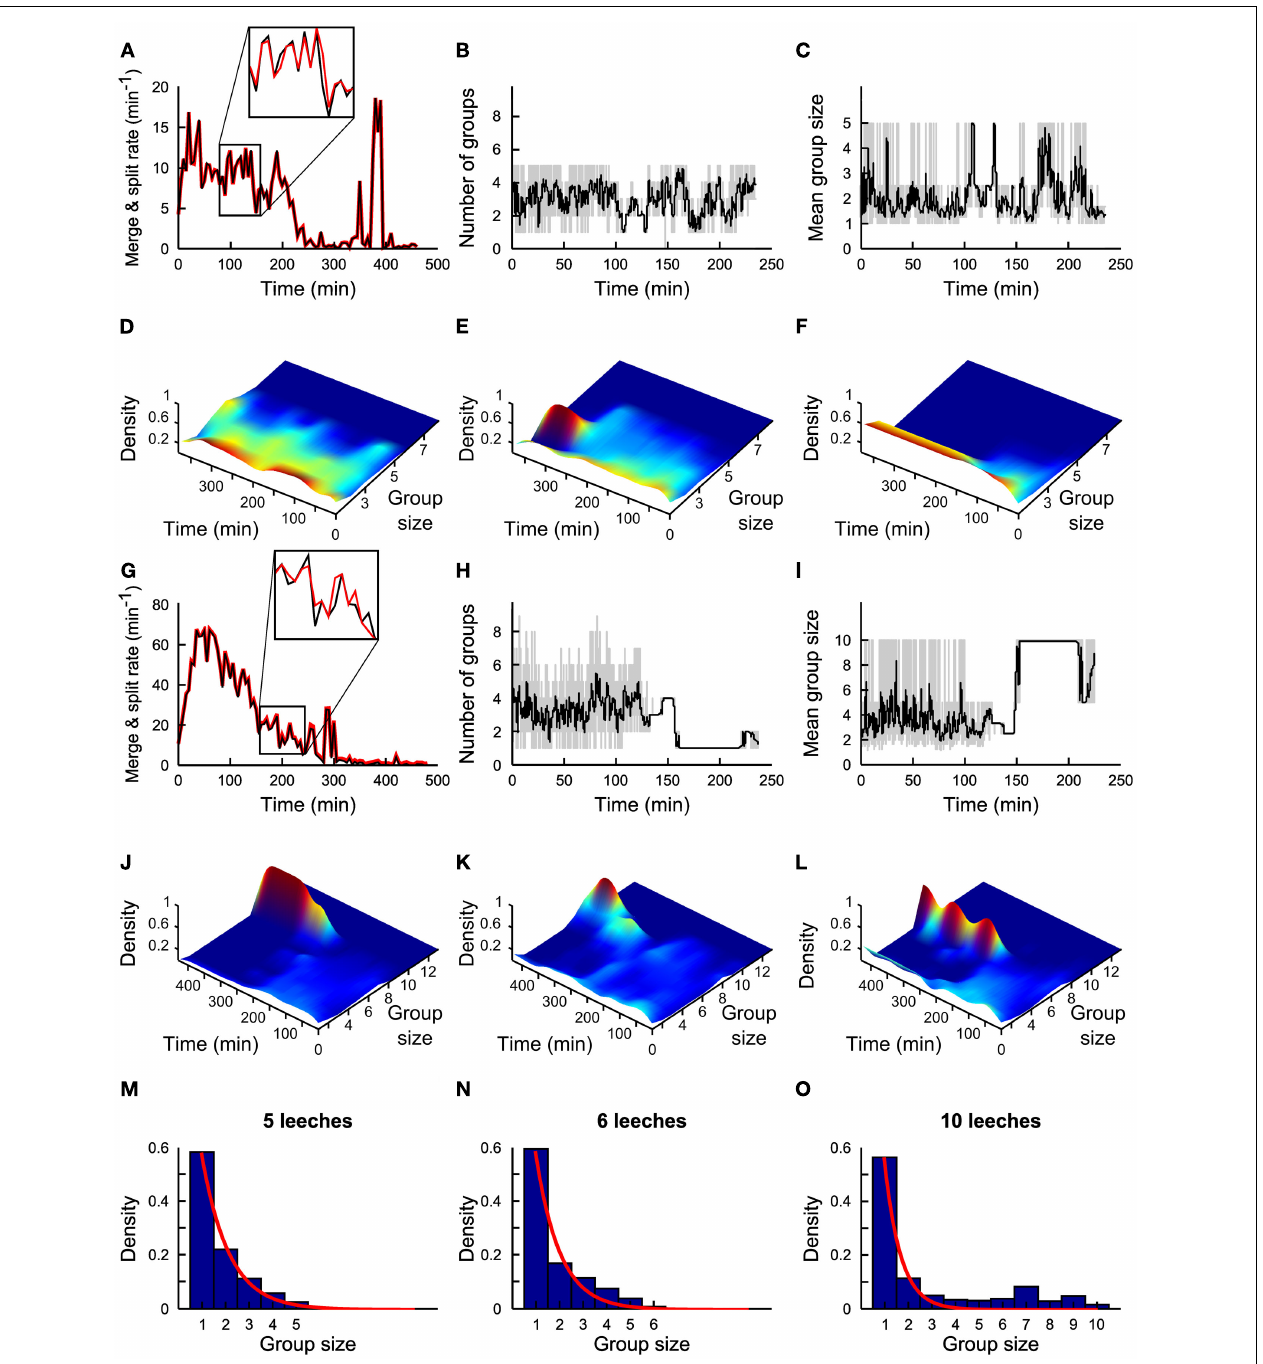
zoom of Merge (black) and Split(red) on an enlarged scale. Merge and split plots are very similar but not identical and small differences determine group formation. (M–O) Probability density of group size in the presence of 5, 6, and 10 conspecifics respectively. Plots in (A,G) are averages from 7 and 10 experiments, respectively. Continuous red lines in panels (M–O) are obtained by fitting the experimental data with an exponential distribution 21 . (B–F) and (H–L) Are based on a single experiment. Plots in (M–O) are averages from 7, 3, and 10 experiments,